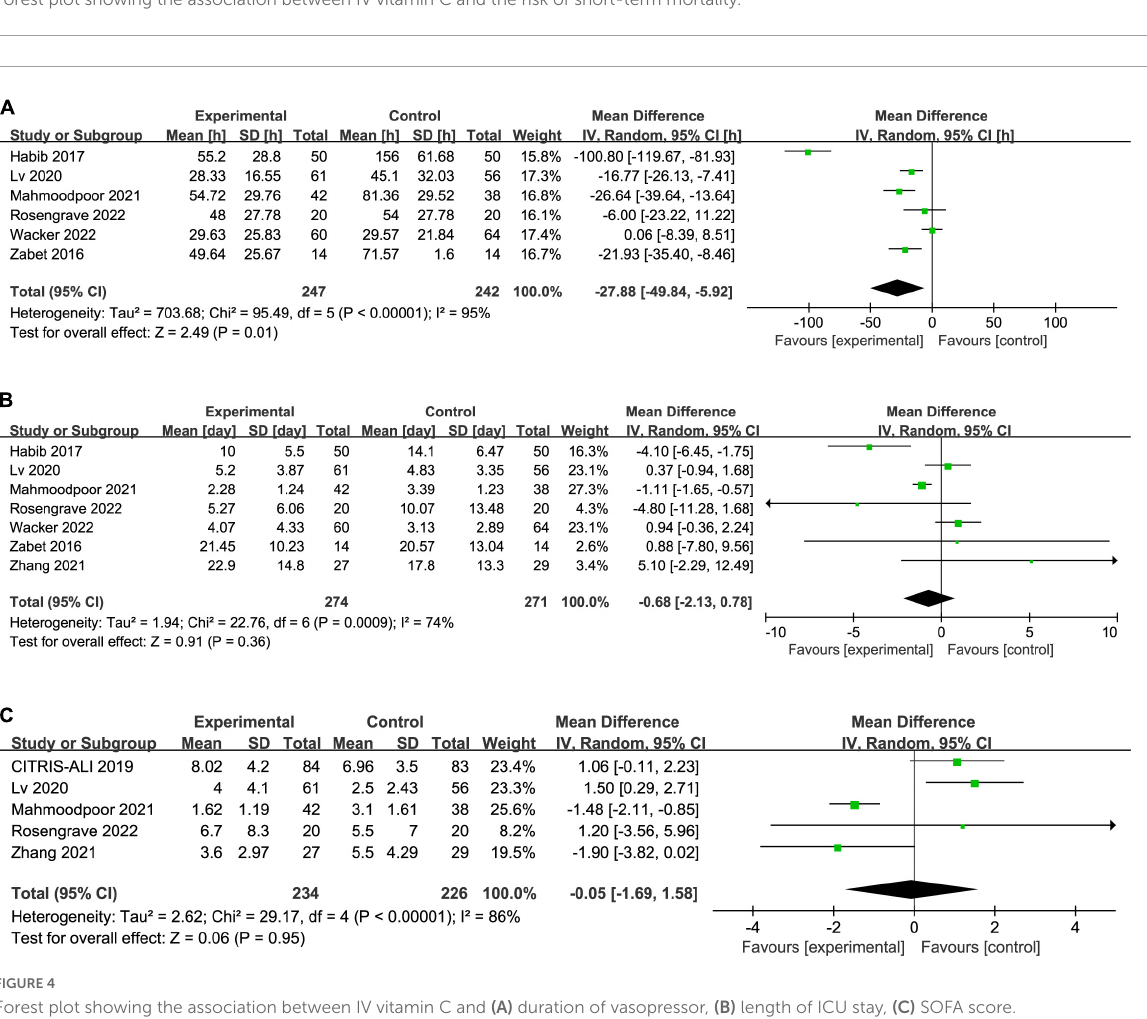
C treatment was associated with a significant lower short- term mortality, whereas with no difference in length of ICU stay and SOFA